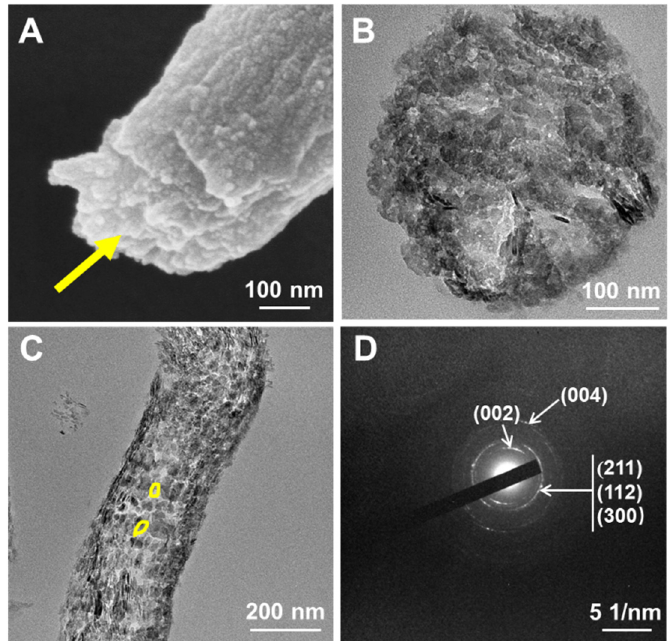
Figure 3. Internal characterization of the collagen fibril with intrafibrillar HAP nanocrystals: ( A ) SEM image of fracture of the fibril (HAP nanocrystals were marked with the yellow arrow). ( B ) TEM image of cross-section of the fibril. ( C ) TEM image of longitudinal section of the fibril (HAP nanocrystals were marked with yellow circles), and ( D ) SAED image of longitudinal section of the collagen fibril.